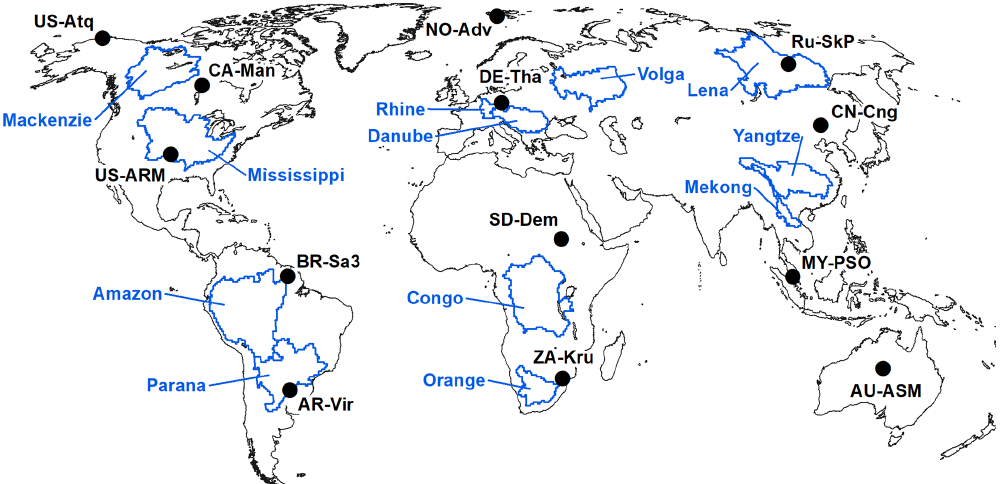
Figure 1. Location of FLUXNET2015 sites used to evaluate ERA5, WFDE5, and WFDEI, as well as river basin outlines for the hydrological